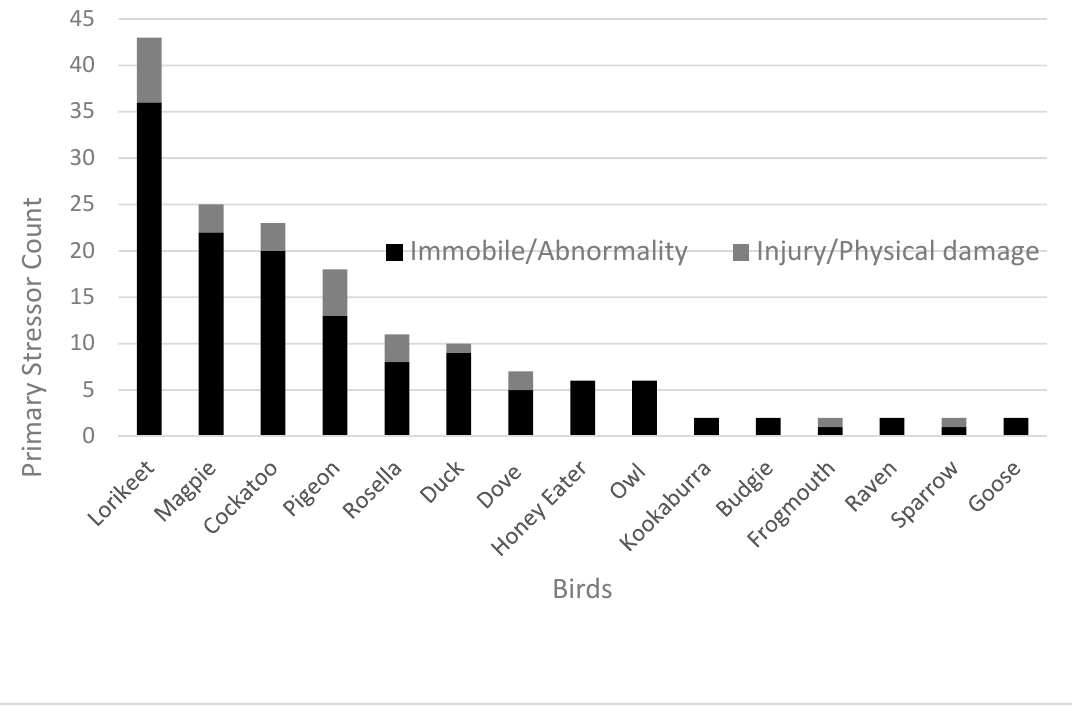
Figure 2. Key primary stressors experienced by the majority of avian patients admitted to the Adelaide Koala and Wildlife Hospital in 2013, 2014, 2016 and 2017 ( n = 173). Note that birds presented to the hospital whose primary stressor was unable to be identified ( n = 5) or those species with a cumulative count of only one primary stressor were omitted from this figure. Primary stressors were pooled into two categories. Immobile / abnormality-related primary stressors comprised of factors such as physical abnormality, abnormal behaviour and immobile. Injury / physical damage-related primary stressors included factors such as dislocation, oil, damaged feet, diarrhoea, superficial injury, feather damage and bleeding. Refer to Supplementary Table S1 to access raw data related to all bird patients.